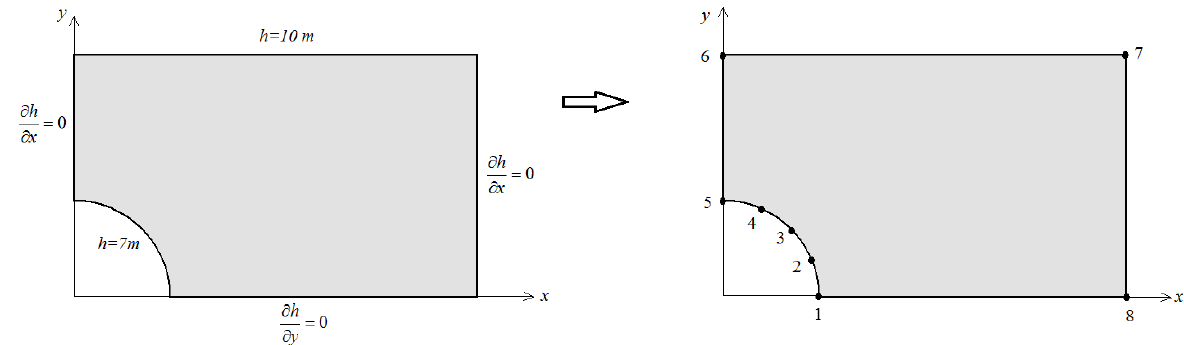
Fig. 3 Boundary conditions and locations of the transformation nodes for mapping of a quarter of the